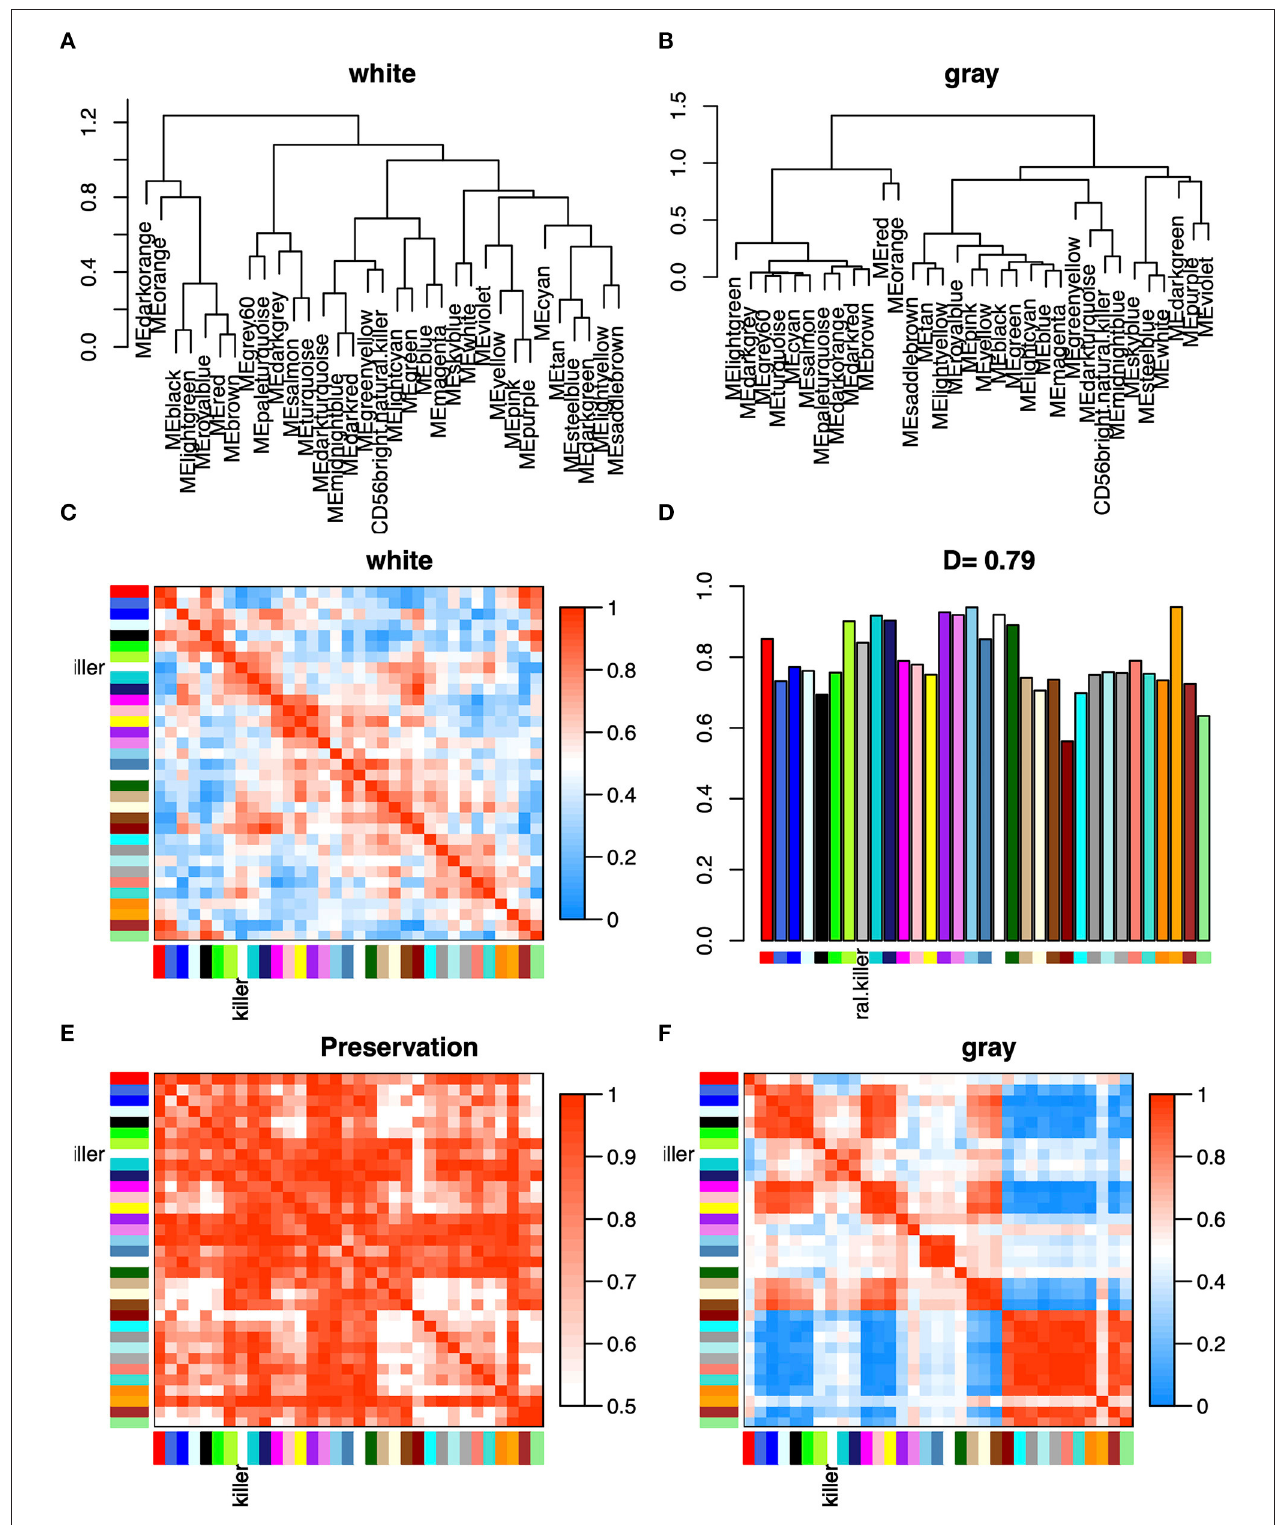
FIGURE 4 | (A,B) Clustering dendrograms of consensus module eigengenes (MEs) for identifying meta-modules show the presence of similar major branchingpatterninWMandGMeigengenenetworks. (C,F)